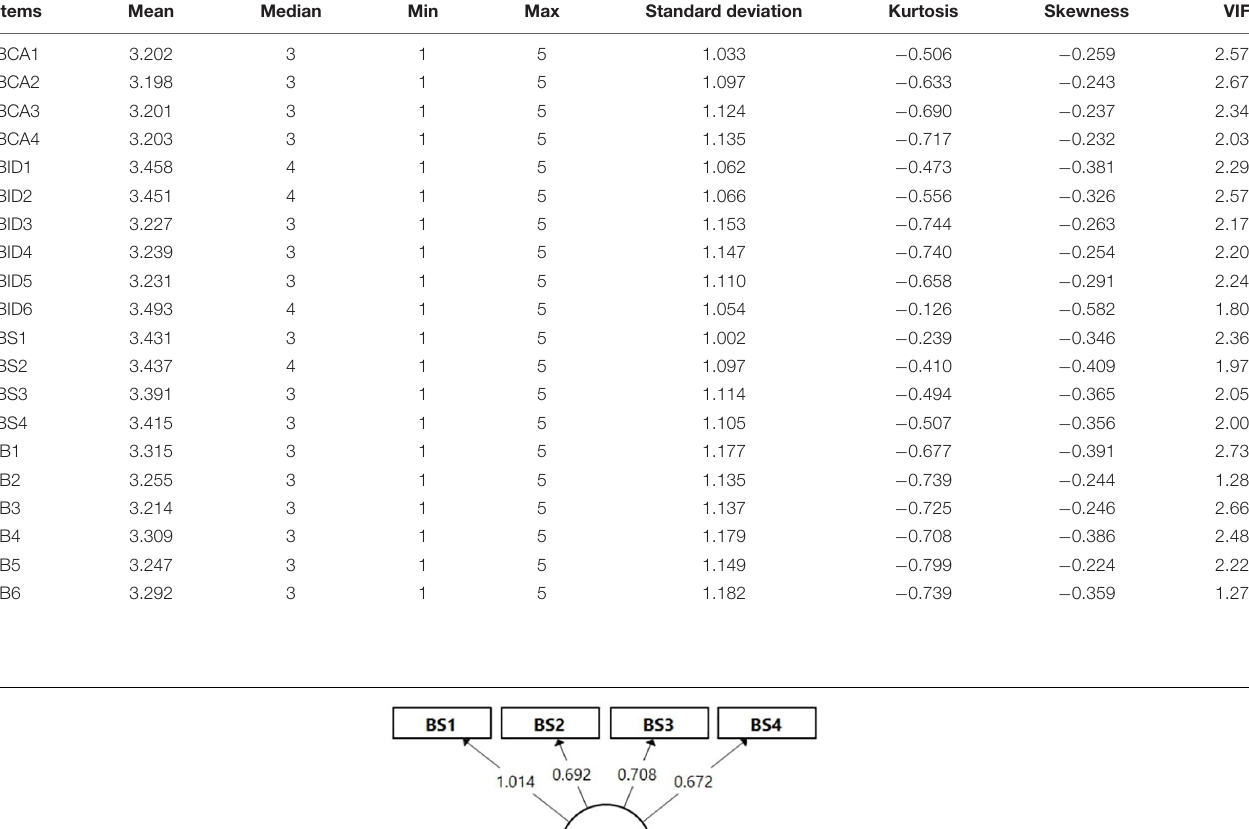
TABLE 2 | Descriptive statistics of indicators.